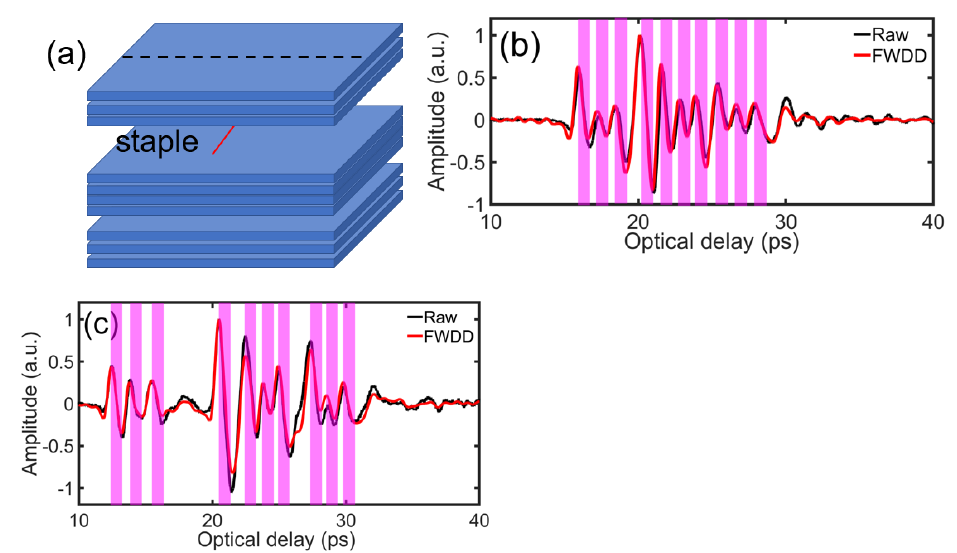
Figure 6. ( a ) Schematic of s = 10 stack with the four central pages stapled together. Raw (black) reflected signal, and FWDD (red) reconstructed signals in THz TOFT data ( b ) away from the staple, and ( c ) near the staple, respectively. The horizontal dashed line near the center of paper stack s = 10, marked ‘cross-section,’ refers to the B-scan presented in Figure 7a,b.